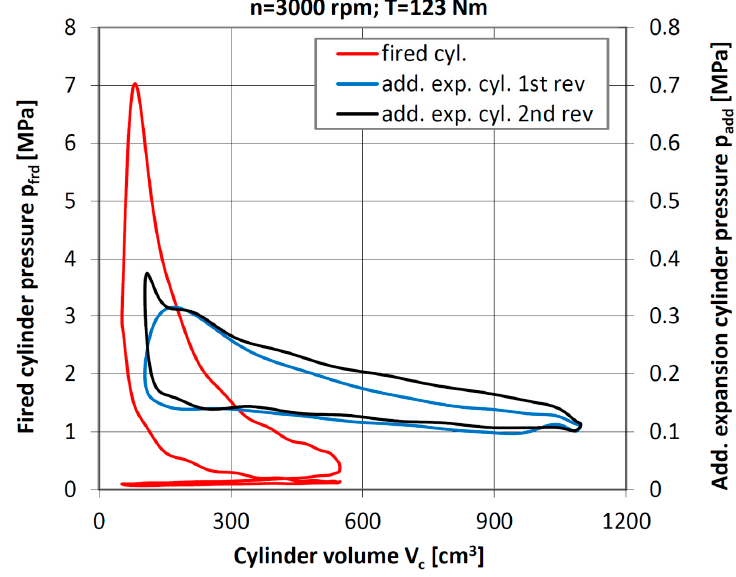
Figure 10. p ‐ V diagrams for the fired cylinder and additional expansion cylinder recorded at 3000 rpm and a torque equal to 123 Nm.